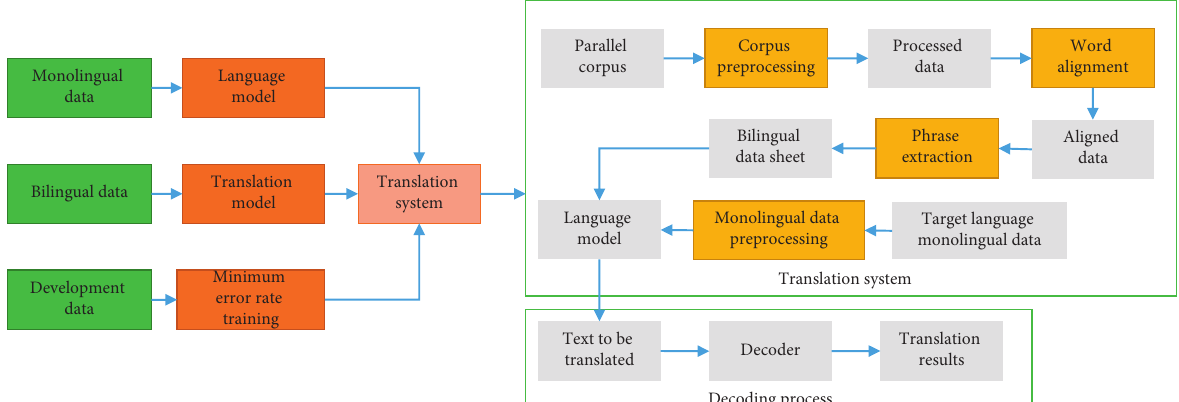
Figure 1: Machine translation system framework.